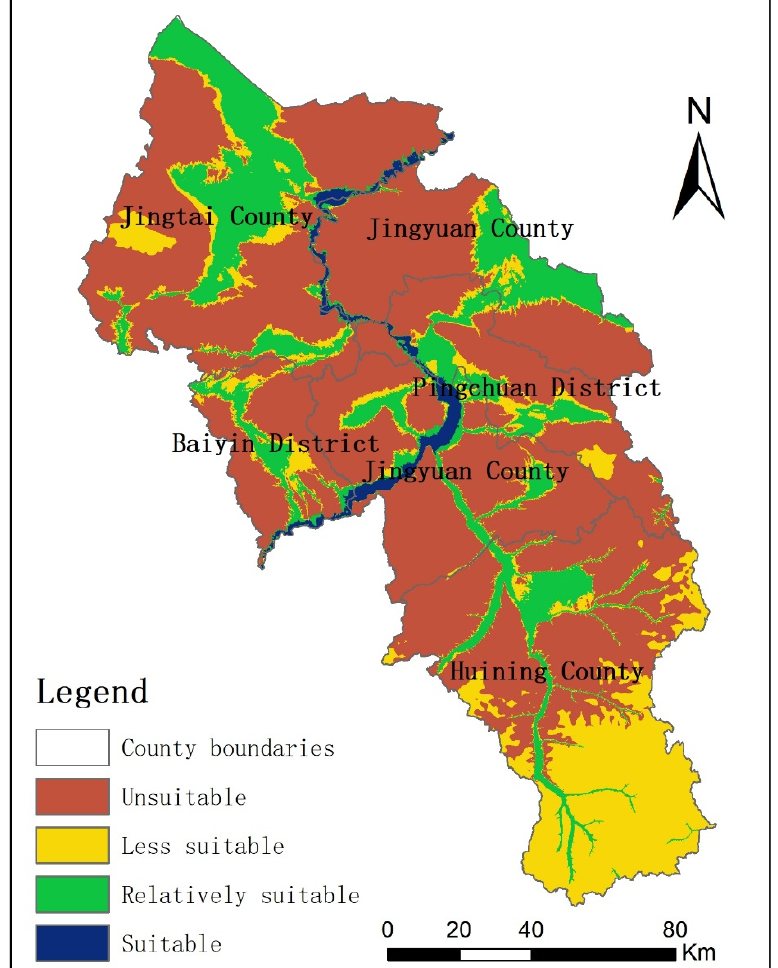
Figure 5. WRSA of Baiyin City.